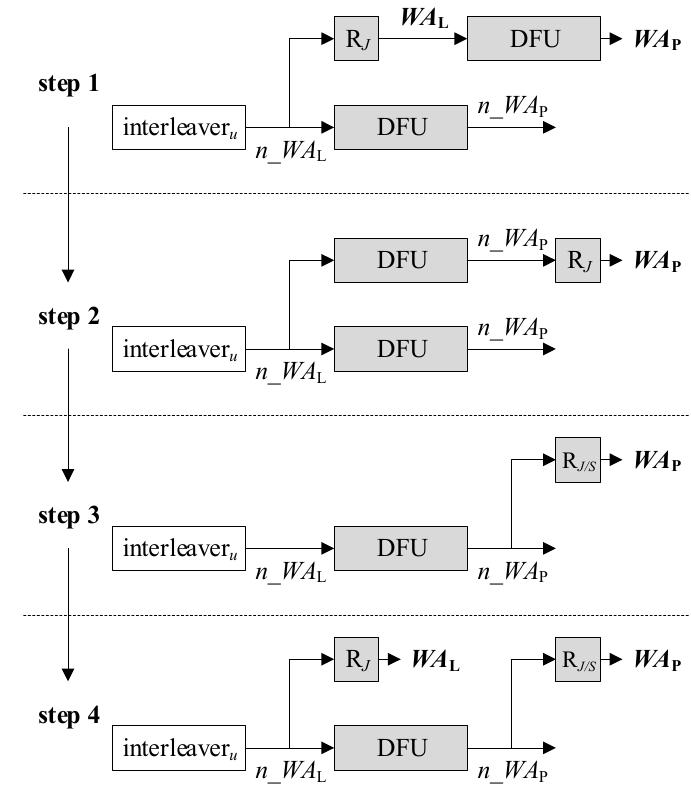
Figure 7. Step-by-step illustration of removing DFU from I-AGU.